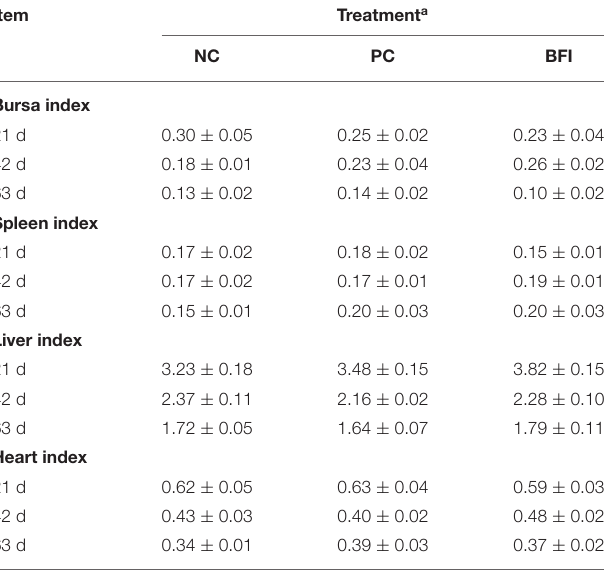
TABLE 3 | Effect of dietary supplementation with heat-inactivated compound probiotics on the blood biochemical parameters in yellow-feathered broilers. Item